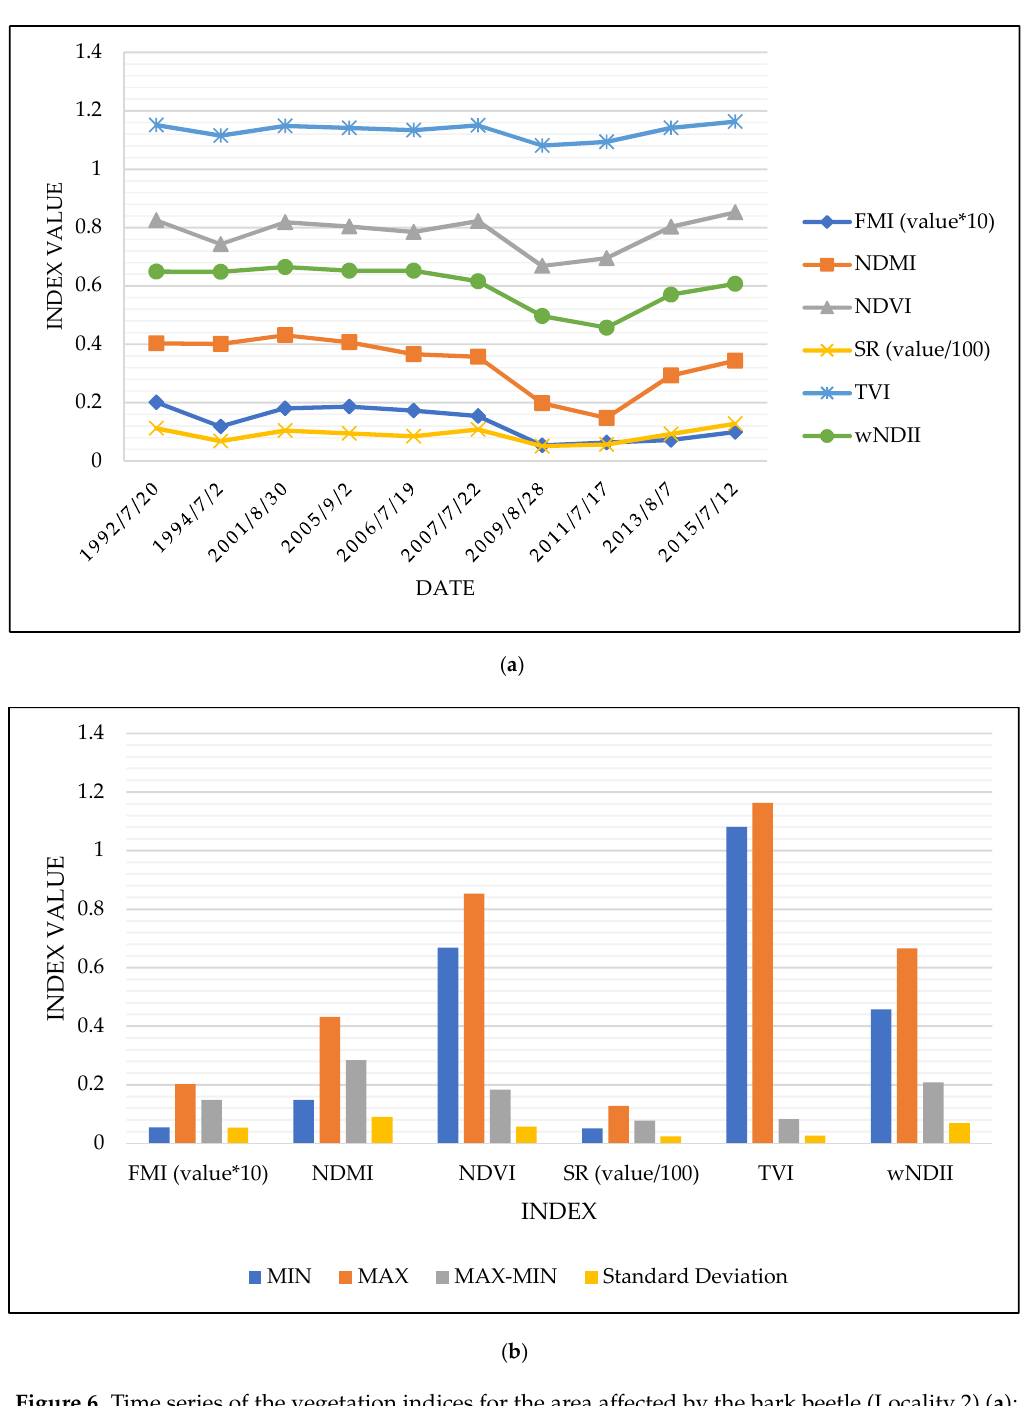
Figure 6. Time series of the vegetation indices for the area affected by the bark beetle (Locality 2) ( a ); and the statistical information ( b ) (Source: Own work).